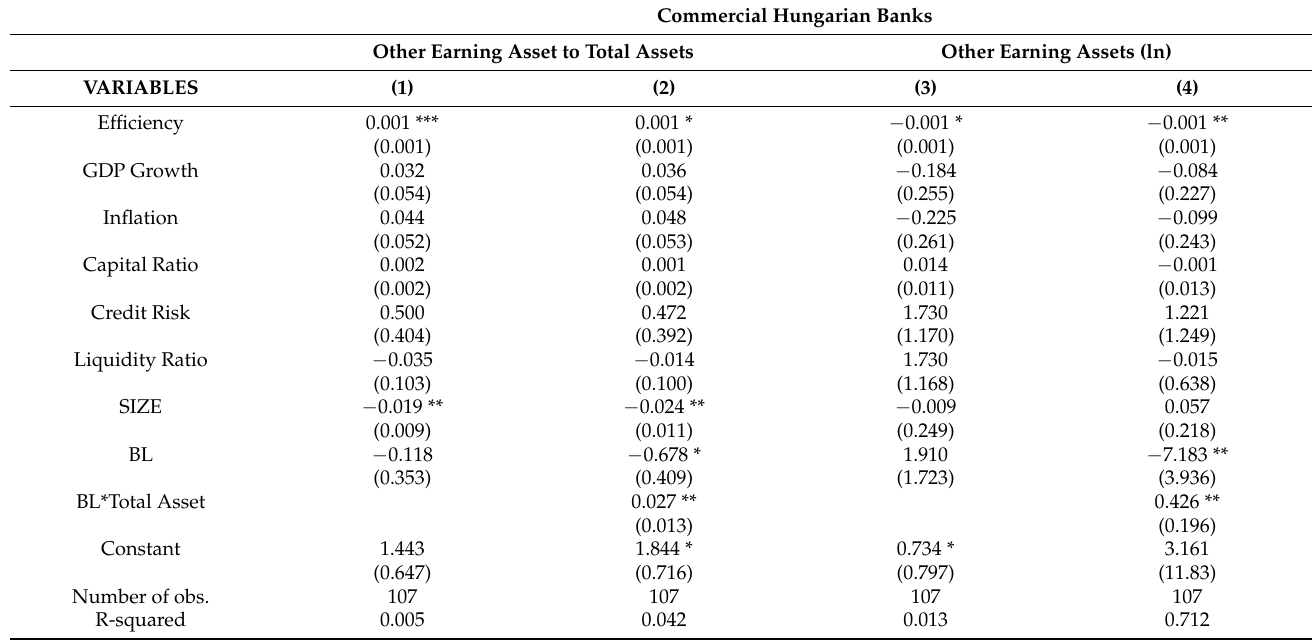
Table A3. Data presenting estimates based on GLS regressions with a random effect on Hungarian commercial banks. Symbols *, **, and *** represent statistical significance at the levels of 10%, 5%, and 1%,